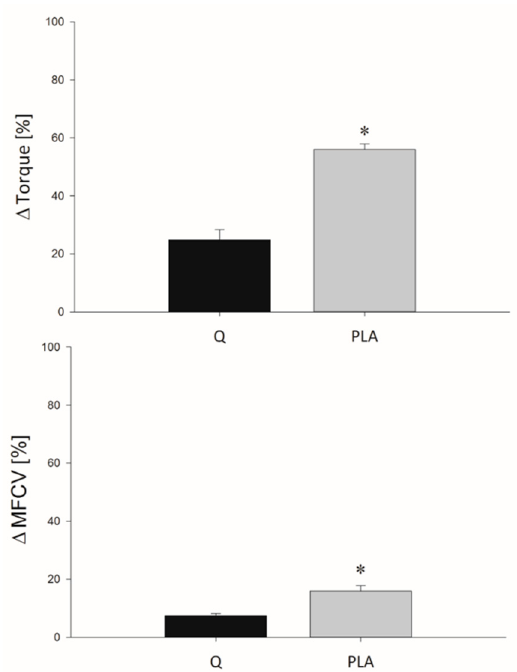
Figure 2. Mean ∆ Torque (upper panel) and ∆ MFCV values (lower panel) obtained at the end of the 10 sets of eccentric exercise (expressed as a percentage of the initial values) in Q (black bars) and PLA (grey bars) conditions. * p < 0.05; significantly different from Q.